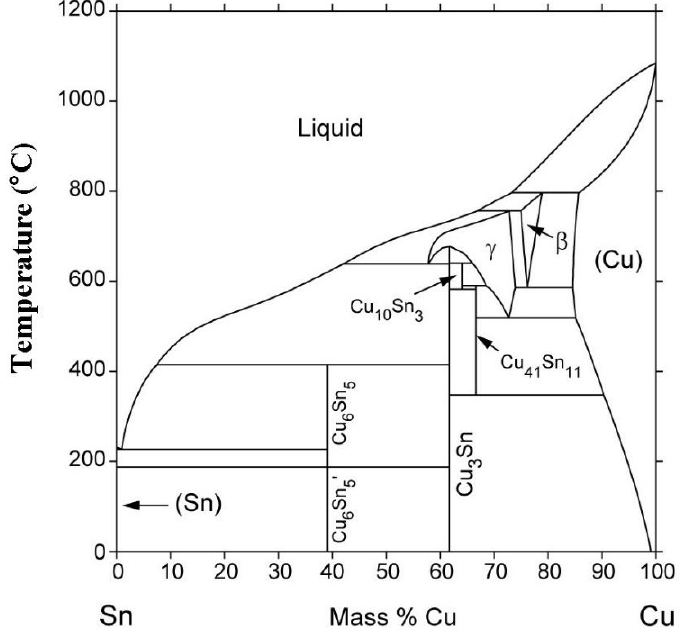
Figure 4. Sn-Cu binary phase diagram (http://www.metallurgy.nist.gov/phase/solder/solder.html (accessed 22 March 2021)). Copyright 2011, with permission from Elsevier.